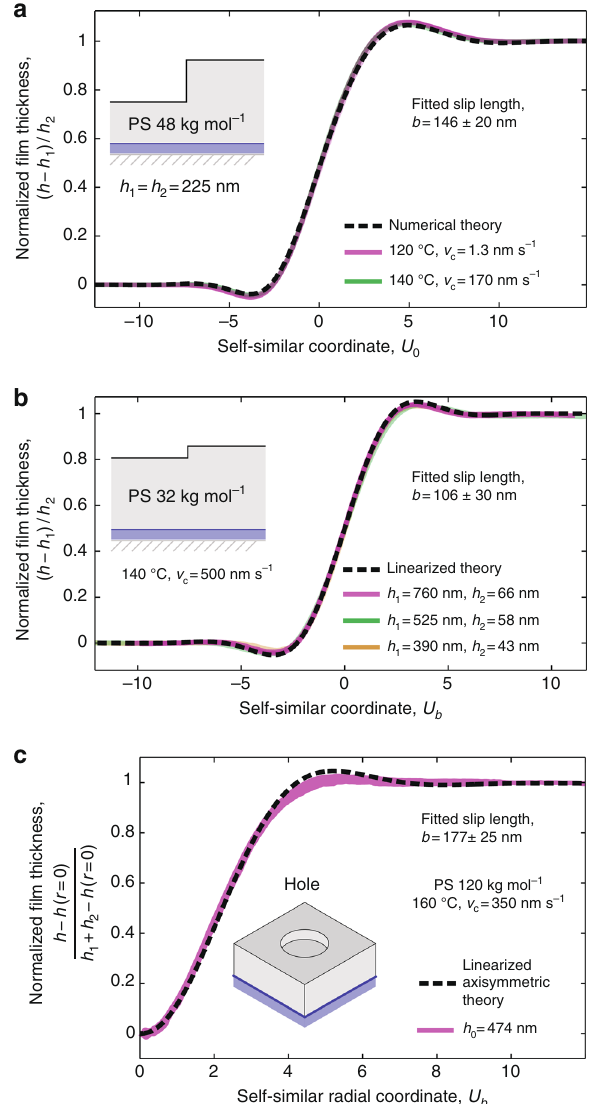
Fig. 2 Capillary leveling as a probe to measure slip length. a – c For three different sample geometries, the rescaled self-similar theoretical pro fi les (dashed lines) fi t the experimentally measured ones (solid lines) with one free parameter, the slip length b . Parameters are indicated in legends, and theoretical details are provided in main text. c The position x is replaced by the radial coordinate